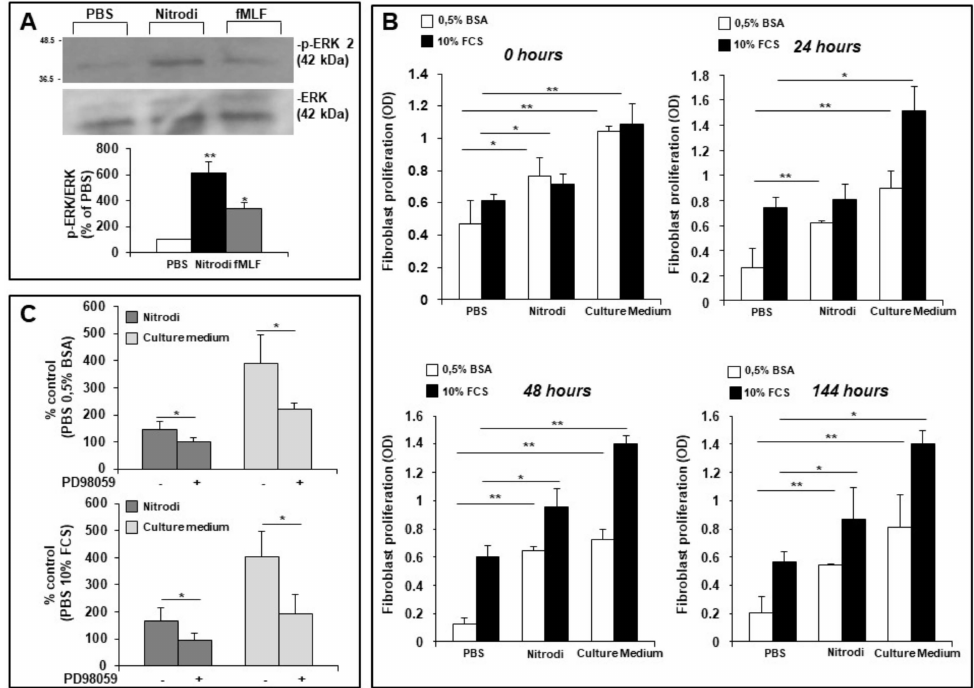
Figure 1. Effects of Nitrodi’s water on BJ cell proliferation. ( A ) Blot imaging and densitometric analysis. BJ cells, after incubation with PBS, Nitrodi, and fMLF for 5 min at 37 ◦ C in a humidified (5% CO2) incubator, were lysed and subjected to Western blot analysis with anti phospho-ERK (p-ERK) antibody and then with the anti-ERK-2 antibody as a loading control. Histogram shows the levels of p-ERK 2 normalized to ERK value and expressed as a percentage of PBS control ( B ) Effects of PBS, Nitrodi, and culture medium on BJ cell proliferation. Cells were grown in 96-well plates for 0, 24, 48, and 144 h in the presence of 0.5% BSA (white column) or 10% FCS (black column). Cell viability was tested using the CellTiter 96 Aqueous One Solution Reagent. Cells treated with Nitrodi supplemented with 0.5% BSA or cells treated with culture medium supplemented with 0.5% BSA were compared to cells treated with PBS supplemented with 0.5% BSA at each time point. Cells treated with Nitrodi supplemented with 10% FCS and cells treated with culture medium supplemented with 10% FCS were compared to cells treated with PBS supplemented with 10% FCS at each time point. Error bars represent standard deviation of the mean of triplicate samples within one experiment. * p < 0.05; ** p < 0.001. ( C ) Effects of a specific inhibitor of the ERK pathway (PD98059) on BJ cell proliferation under starving and growing conditions. Cells were pre-treated with PD98059 and exposed to PBS (as control), Nitrodi’s water (dark grey columns), or culture medium (light grey columns) supplemented with 0.5% BSA or 10% FCS. Cell viability was tested using the CellTiter 96 Aqueous One Solution Reagent at 24 h after the treatments. Results are expressed as a percentage of the control (PBS 0.5% BSA or PBS 10% FCS). Values are mean ± SEM of three experiments. * p <